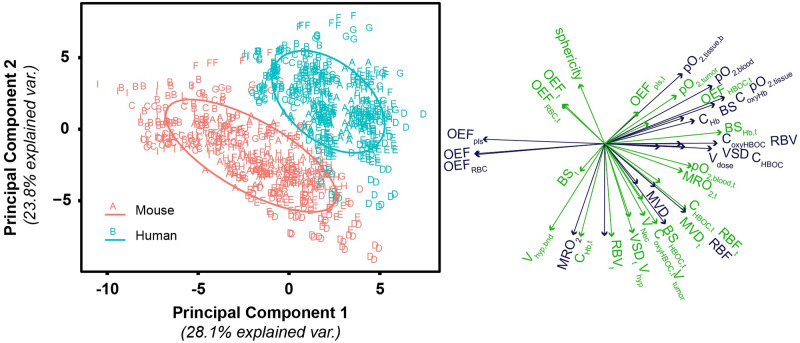
PCA biplot for principal components 1 and 2 of the mouse and human tumor model.In this figure, groupings are organized by organism type (human, mouse). Left: PC scores for tissue and O2 delivery for each of the simulated tumor treatments. Ellipses are drawn around each group with 68% of the normal probability. Right: Loading plots relating how each parameter influences the corresponding principal component. Green vectors indicate tumor properties while blue vectors indicate host tissue properties. Labels indicate the corresponding tumor property.